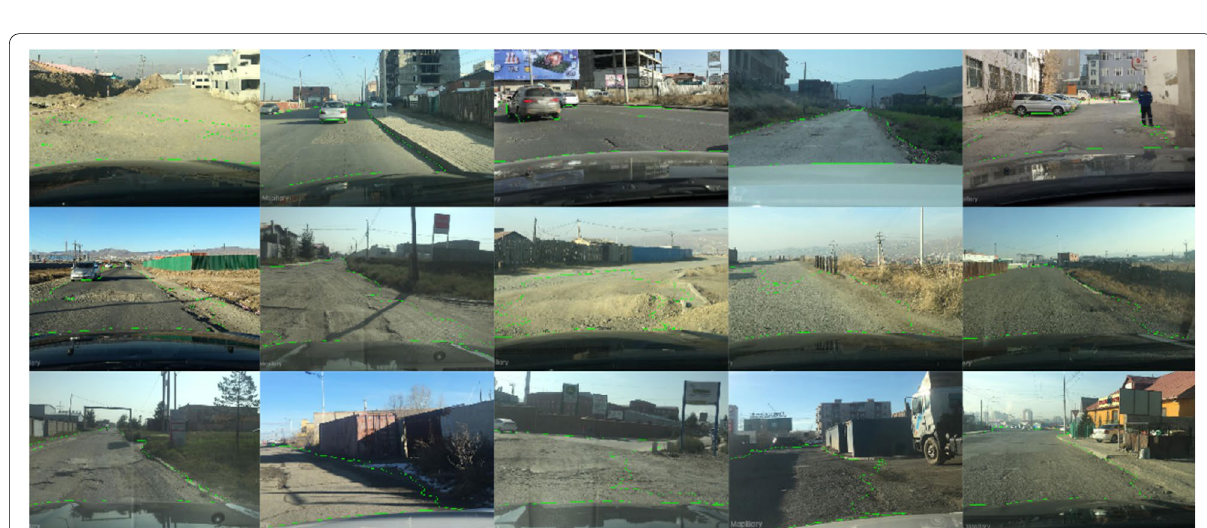
Fig. 25 Roadway images with low